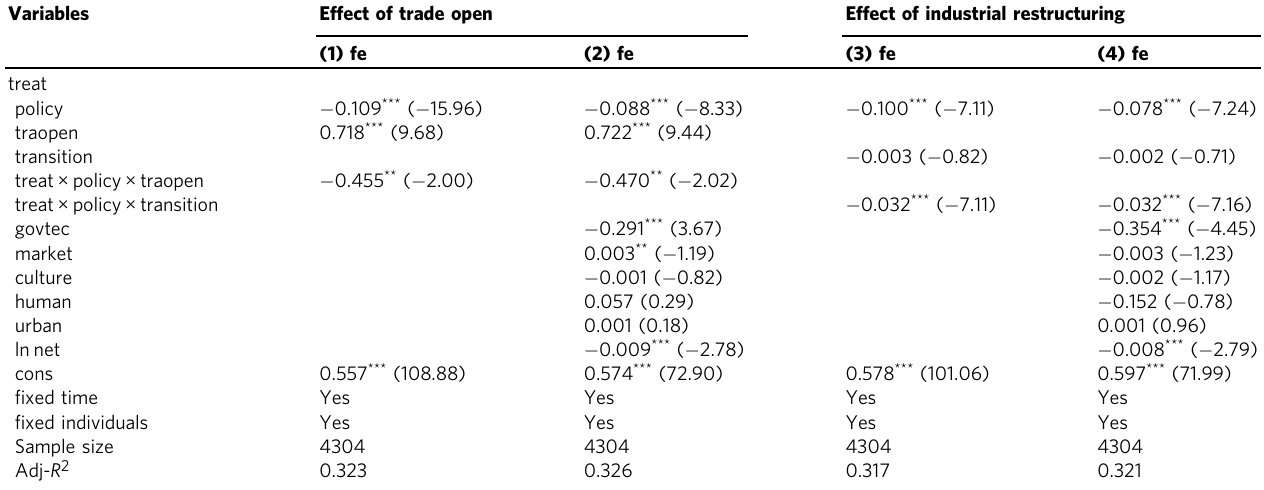
Table 7 Result of mechanism test.